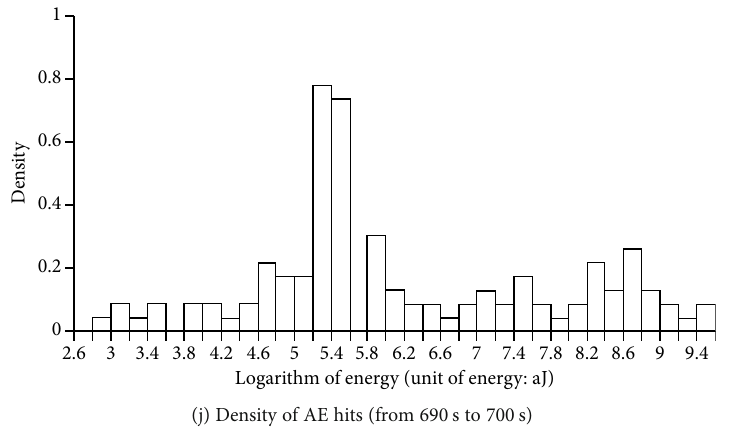
Figure 7: Energy distribution of AE hits (note: the red curve is the fi tting result with the Burr distribution model).